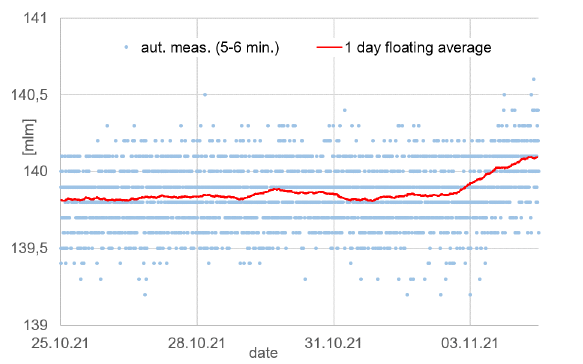
Fig. 13. H248 water level variance (ultrasound